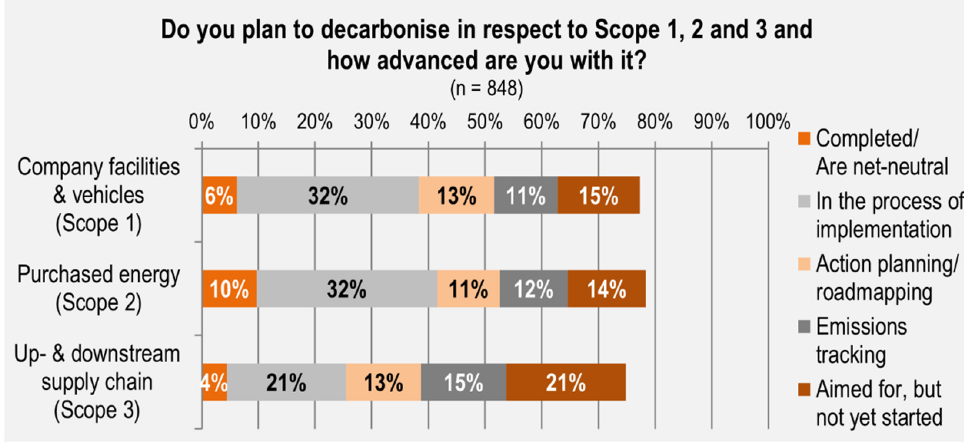
Figure 5. Companies’ plans and current state in respect to Scope 1–3 [43]. (3) Approaching emissions from a different, a product angle: are only those emissions